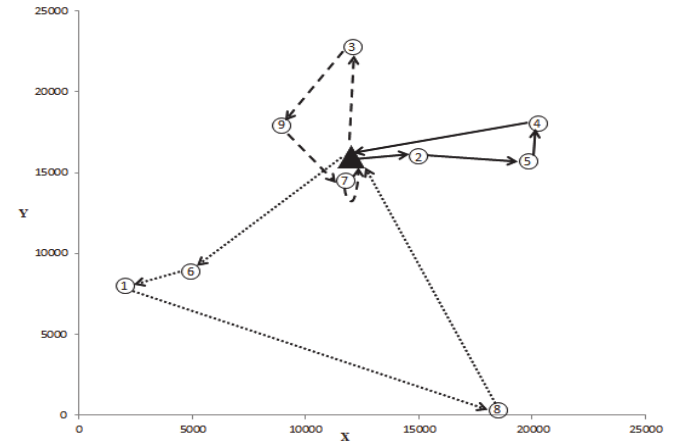
Fig. 3. Tours of vehicles by neglecting the time dependency on travel